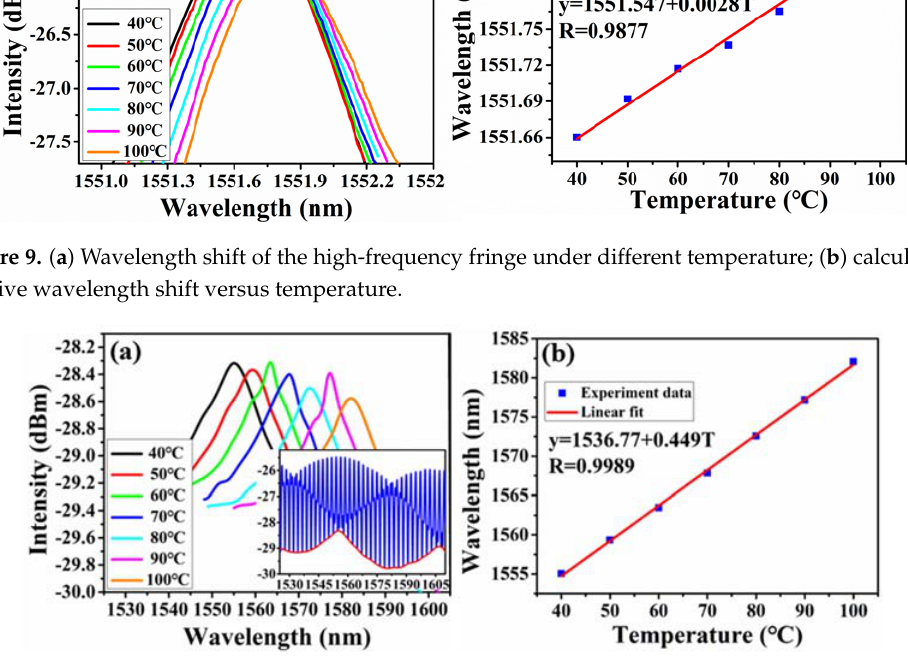
Figure 10. ( a ) Wavelength shift of the lower envelope under different temperature; ( b ) calculated relative wavelength shift versus temperature.